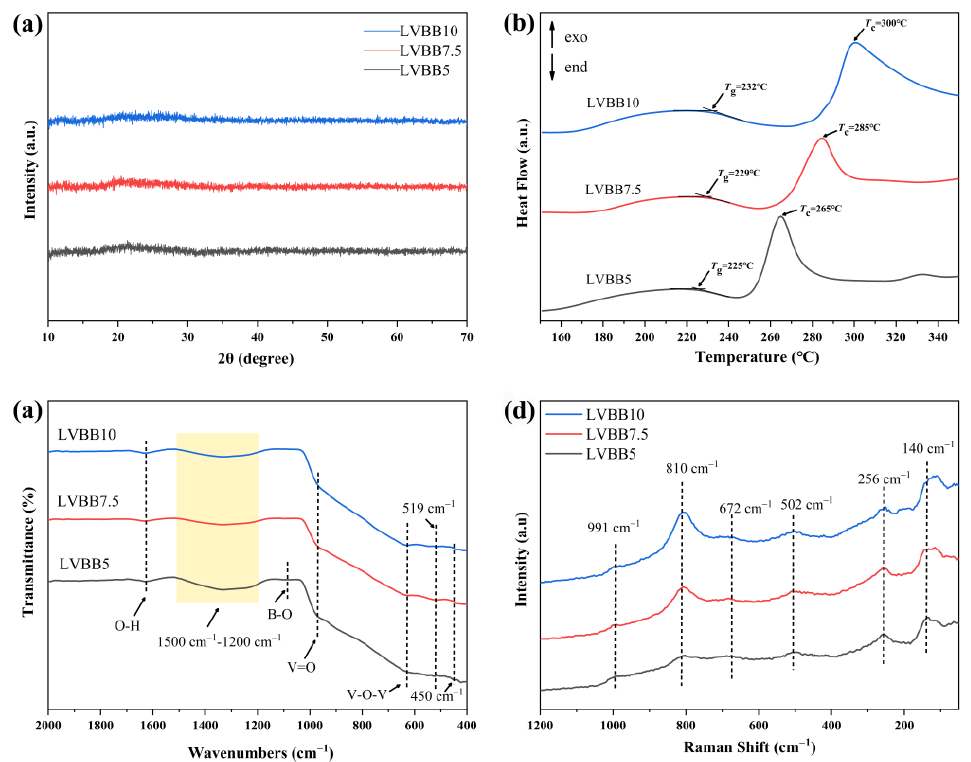
Figure 1. ( a ) XRD patterns, ( b ) DSC curves, ( c ) infrared spectra and ( d ) Raman spectra of